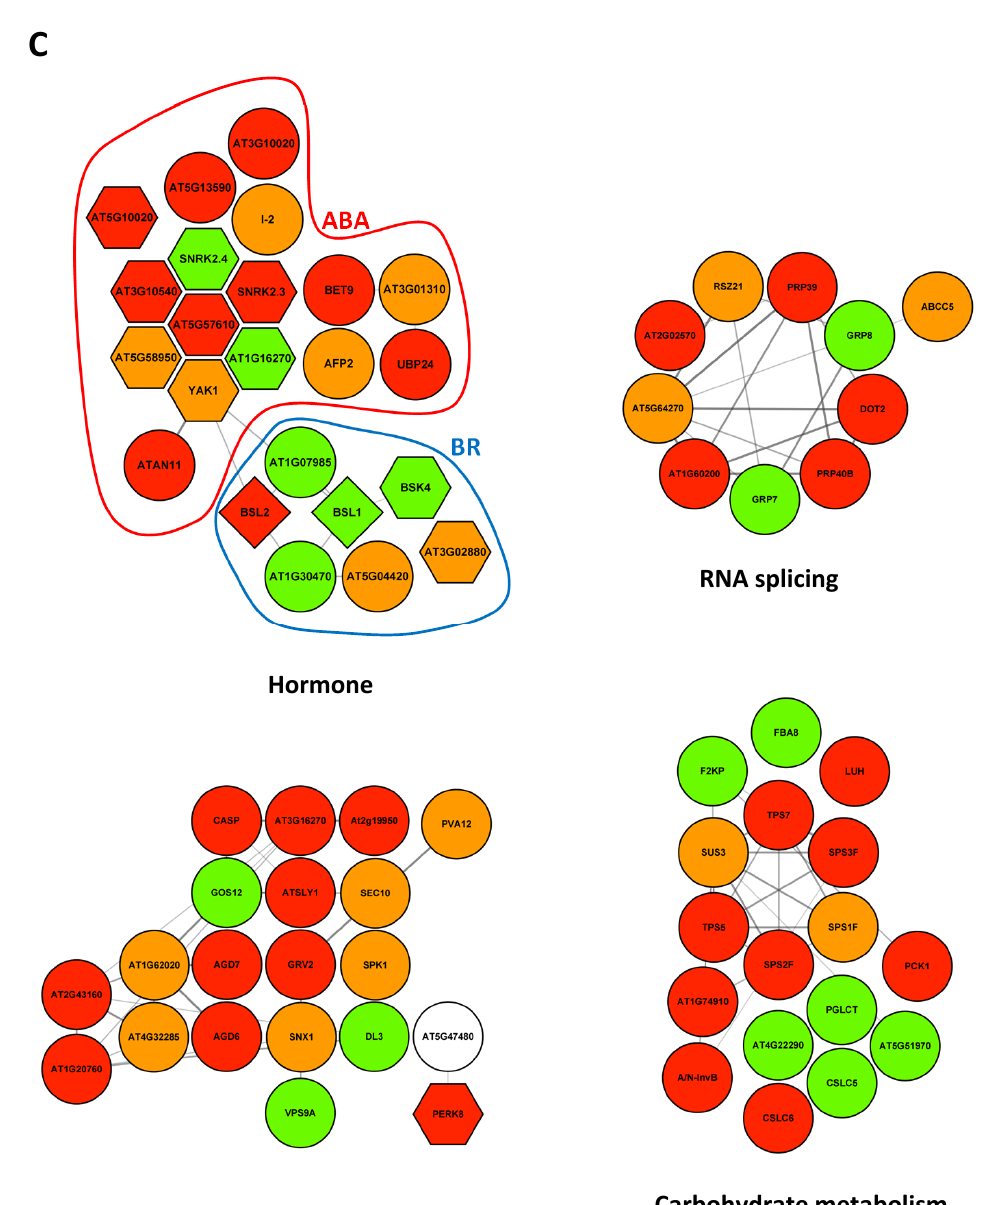
Figure 9. Quantitative changes in seed protein phosphorylation during imbibition. ( A ) Cluster analysis of the 489 phosphopeptides quantified in DI and LI seeds. ( B ) Association network of phosphoproteins undergoing changes in phosphorylation level during imbibition. Protein–protein interactions with a confidence cut-off over 0.4 were retrieved from the STRING application and used to construct a phosphoprotein network. Red and green nodes represent proteins with increased (cluster 1–3) or decreased (cluster 5–6) phosphorylation following imbibition, respectively. Orange nodes refer to proteins undergoing transient phosphorylation (cluster 4). Proteins exhibiting an opposite profile at different phosphosites are represented as white nodes. ( C ) Close-up of selected network regions corresponding to biological functions over-represented in the phosphoprotein dataset.